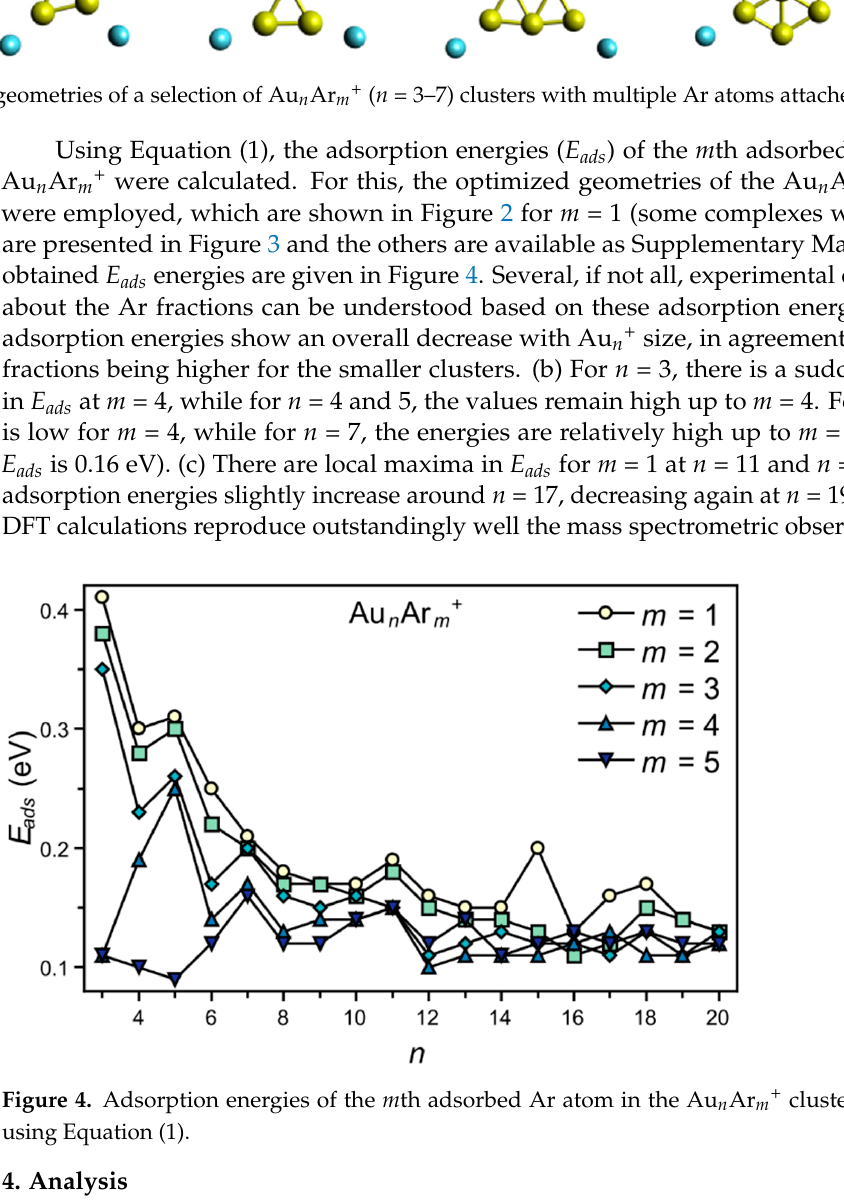
Figure 4. Adsorption energies of the m th adsorbed Ar atom in the Au n Ar m + clusters, calculated us- ing Equation (1).